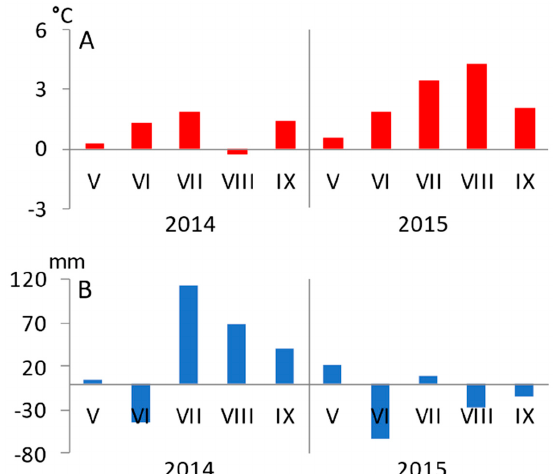
Figure 5. Deviations in monthly (May–September; in Roman numerals V–IX) air temperature (part A ; ◦ C) and precipitation totals (part B ; mm) from long-term mean (normal) of